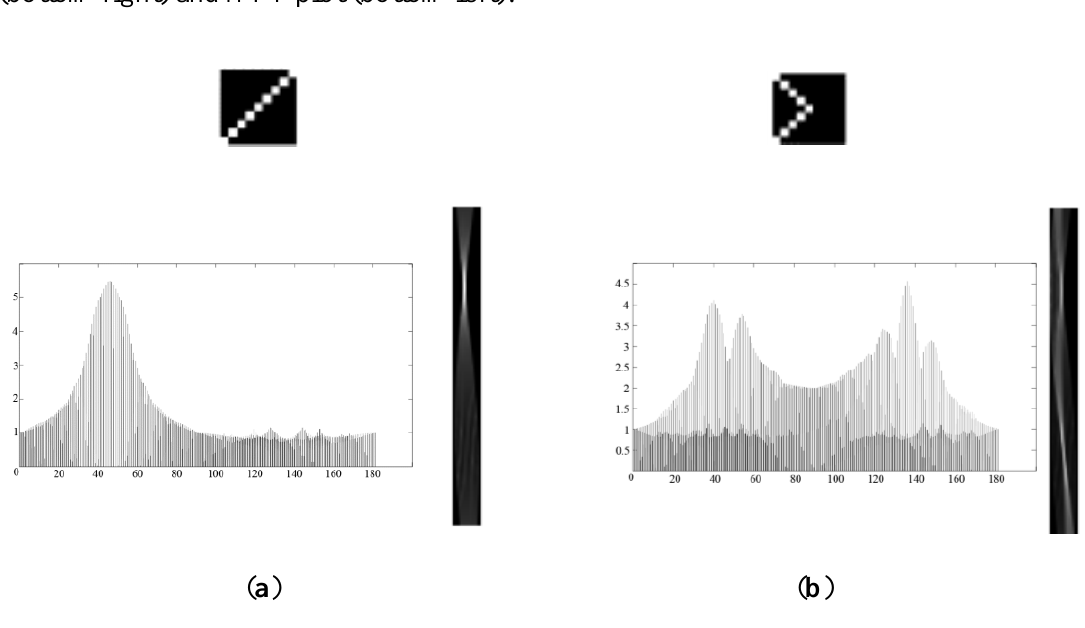
Figure 4. Different MPT representation peaks in ( a ) NCM (top), its MPT representation (bottom-right) and MPT plot (bottom-left); ( b ). PUCM (top), its MPT representation (bottom-right) and MPT plot